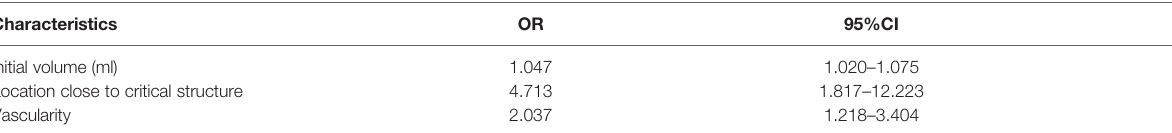
TABLE 4 | Multivariate logistic regression analysis of